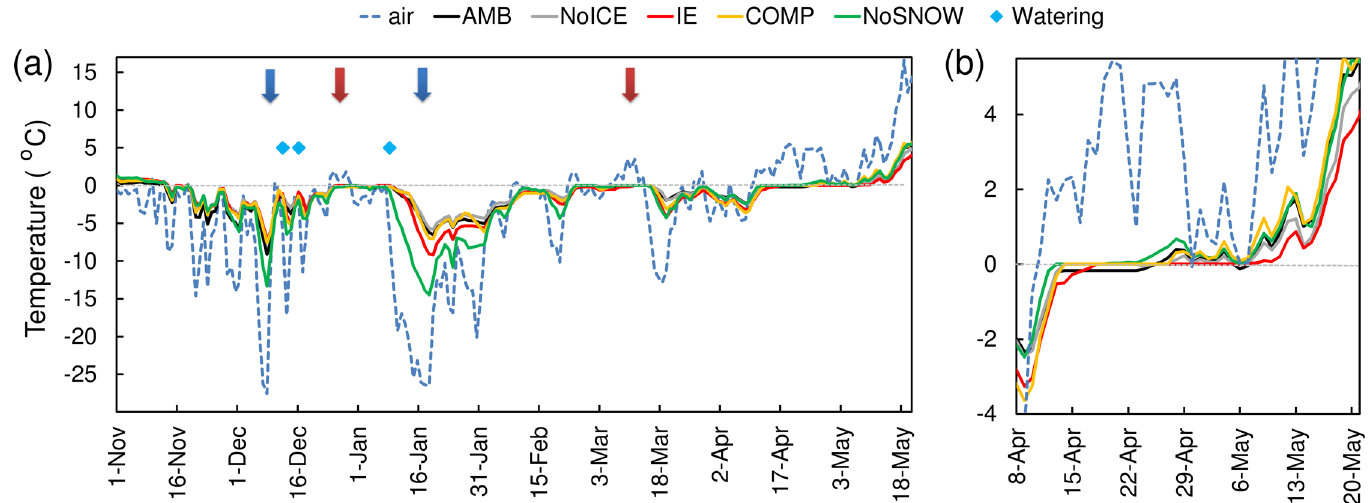
Fig 2. Air temperature and effect of snow manipulation on soil temperature. Mean daily air (2-m height) and soil (humus layer) temperatures during winter 2013 – 2014 (a) and close-up at the time of snow melt (b). Values are mean of 3 blocks. Snow watering occasions are indicated. Blue arrows = cold spells, red arrows = warms